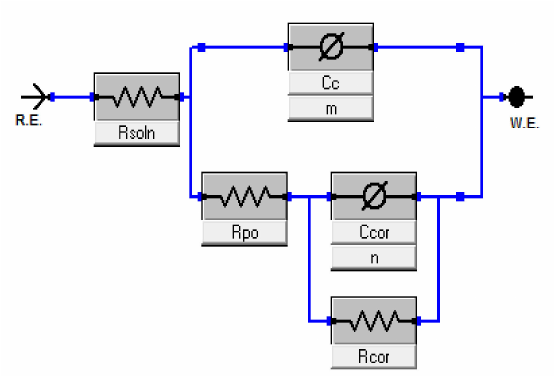
Figure 11. Equivalent circuit used to fit the experimental data in the multilayer systems